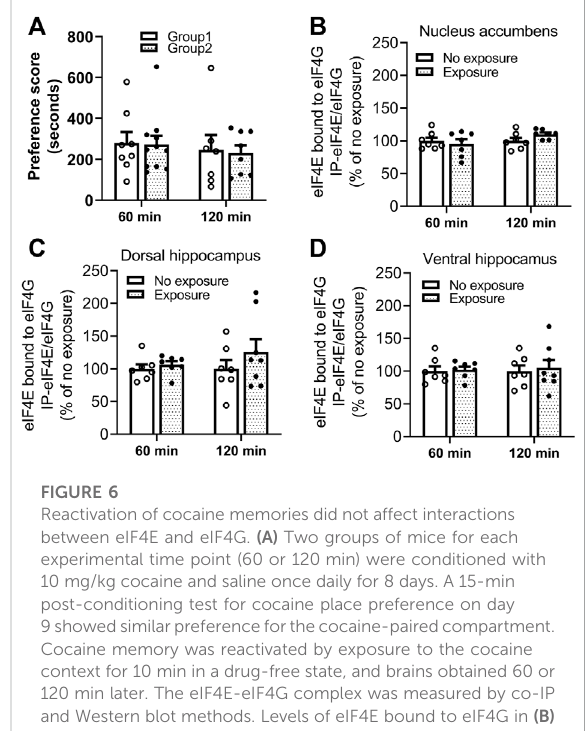
FIGURE 6 Reactivation of cocaine memories did not affect interactions between eIF4E and eIF4G. (A) Two groups of mice for each experimental time point (60 or 120 min) were conditioned with 10 mg/kg cocaine and saline once daily for 8 days. A 15-min post-conditioning test for cocaine place preference on day 9showedsimilarpreferenceforthecocaine-pairedcompartment. Cocaine memory was reactivated by exposure to the cocaine context for 10 min in a drug-free state, and brains obtained 60 or 120 min later. The eIF4E-eIF4G complex was measured by co-IP and Western blot methods. Levels of eIF4E bound to eIF4G in (B) nucleus accumbens, (C) dorsal hippocampus, and (D) ventral hippocampus were not signi fi cantly different in mice exposed to the cocaine context compared to the mice with no re-exposure. Data are expressed as % of no exposure controls, and means ± SEMs are shown. N = 7 –